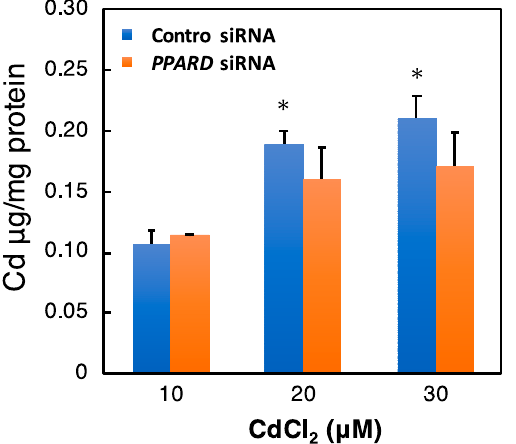
Figure 7. Effect of PPARD knockdown on the intracellular Cd concentration. After treatment with PPARD siRNA for 48 h, HK-2 cells were treated with Cd for 12 h. The Cd concentration was measured by an atomic absorption spectrometer. Values are means ± SD ( n = 3). * Significantly different from the control siRNA + Cd 10 µM group, p < 0.05.